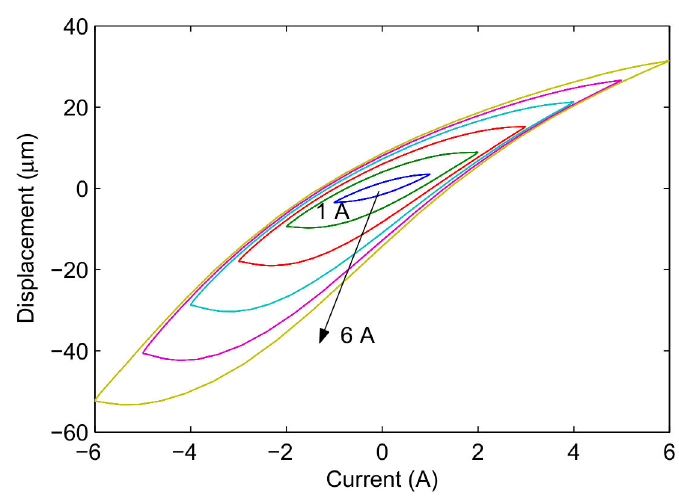
Figure 5. Displacement–current relationship of the magnetostrictive actuator with di ff erent excitations: